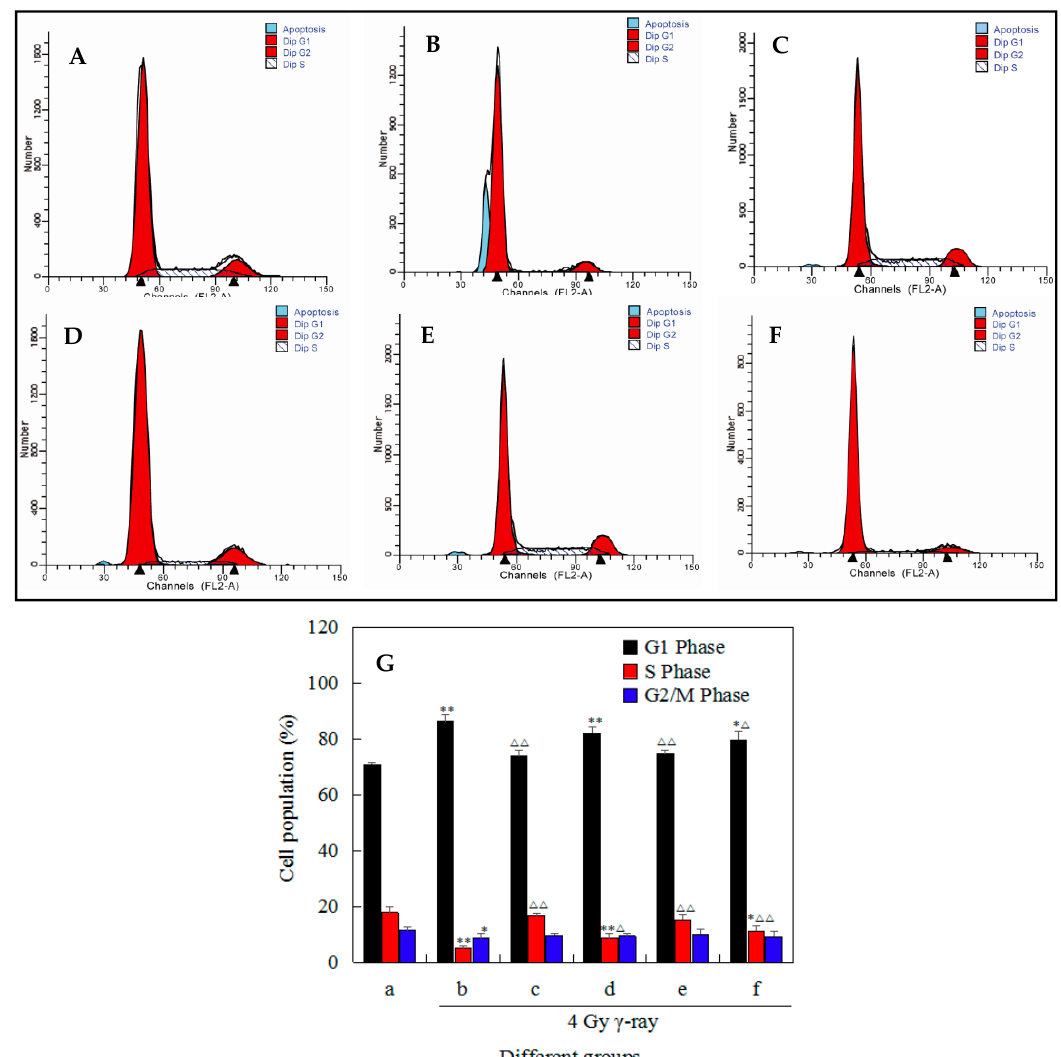
Figure 3. Cell-cycle analysis of splenocytes in different groups ( n = 6). ( A ) Group I: Normal group; ( B